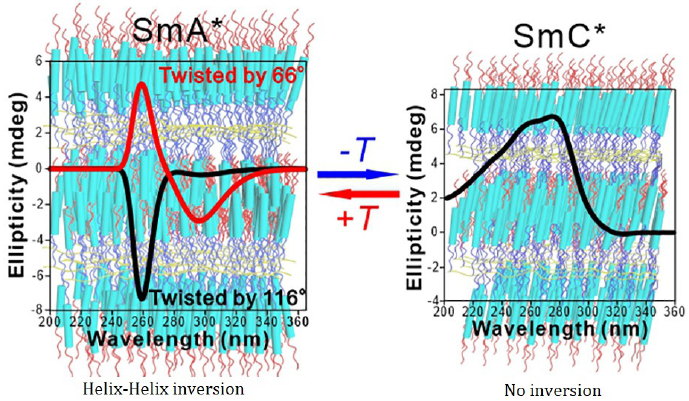
Figure 6. Inversion of chirality observed in PChMA-b-PMMA BCP measured through circular dichroism (CD) experiments. The graphs show the plots of ellipticity, measured as a function of wavelength in chiral SmA and SmC phases. The blue rods represent the LC mesogens arranged in layer structures. T represents the temperature. Reprinted with permission from Krishnasamy et al.,